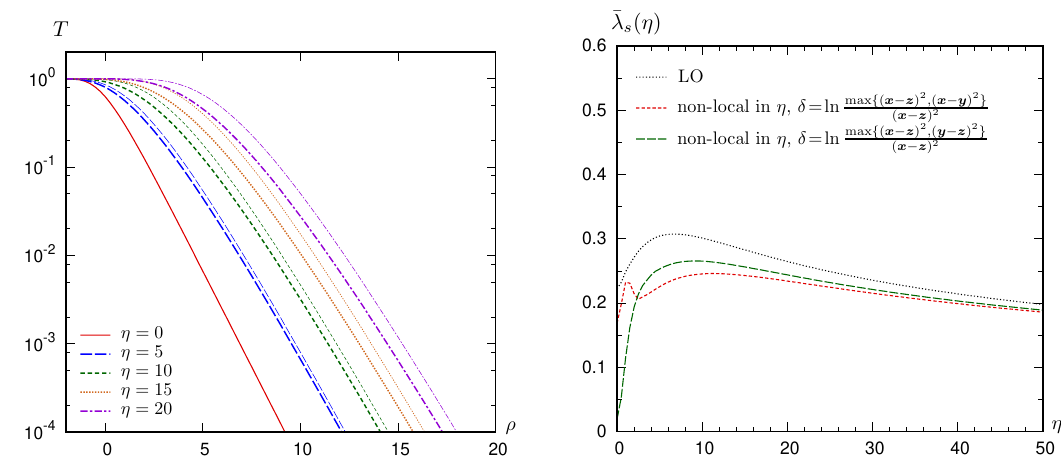
Figure 9 . Left: the amplitude as obtained from running coupling evolution (and where the scale in the coupling is set to run with the smallest of the sizes of the three dipoles). Thick lines stand for the solutions to the non-local equation (6.1), while thin lines stand for those obtained from LO BK. Right: the speed of the fronts as a function of (cid:17) , for running coupling evolution according to the non-local equation (6.1) (for two di(cid:11)erent (cid:14) -shifts) and for LO BK. prescriptions for the rapidity shift are rapidly converging to each other with increasing (cid:17) , but they remain visibly smaller than the respective LO result, up to rapidities as large as (cid:17) =